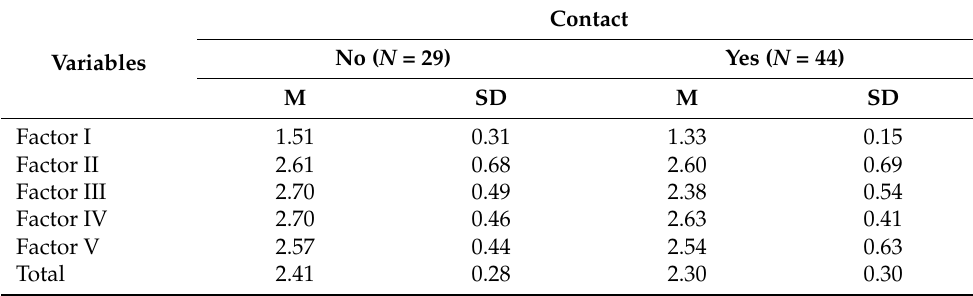
Table 7. Mean and standard deviation of perceptions of attention to diversity based on contact.